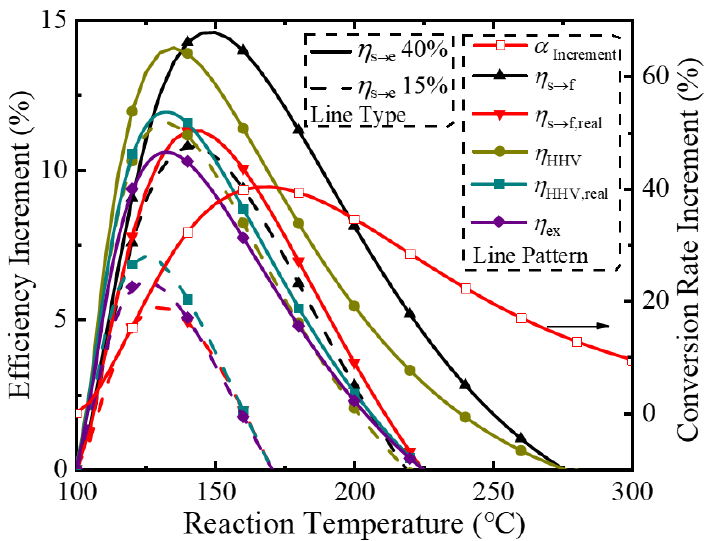
Figure 9. Increment of thermodynamic efficiency and conversion rate compared with those in a traditional reactor versus reaction temperature for a permeate pressure of 0.2 bar.